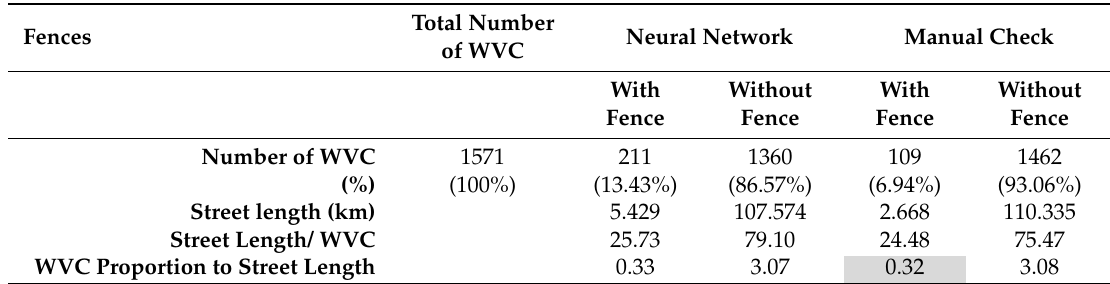
Table 3. Results of WVC numbers at roads with and without fences for the road segments identified by ANN in comparison to the manual classification.